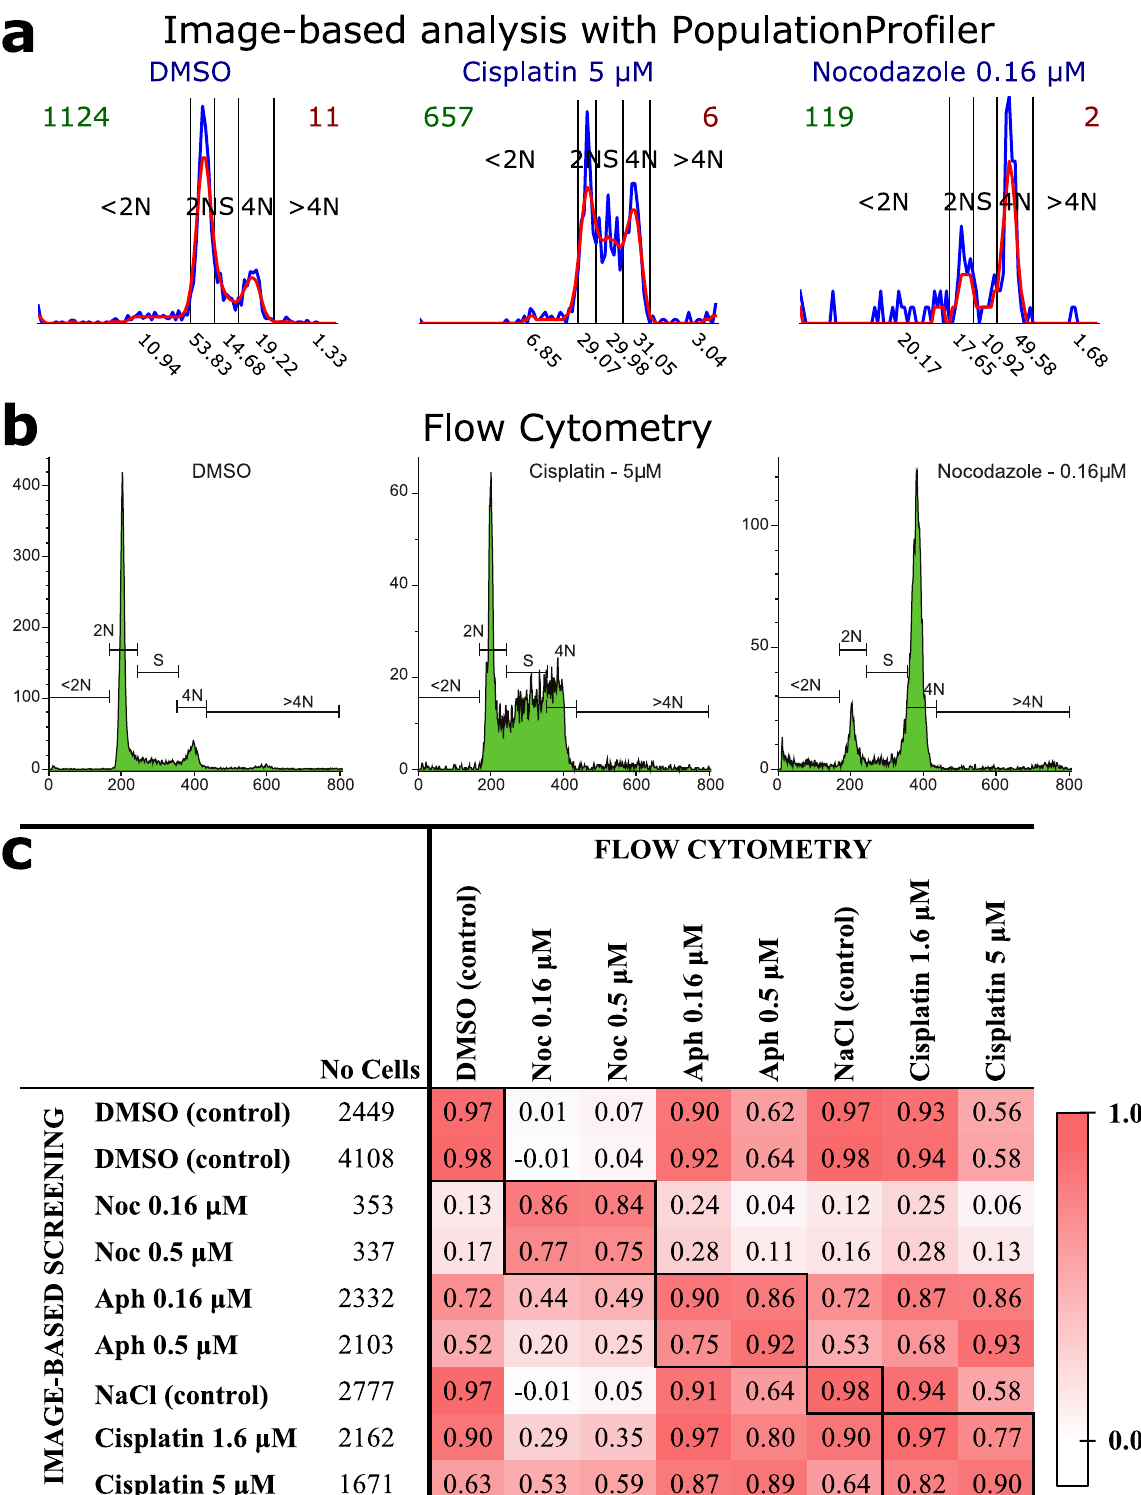
Fig 1. Image-based cell cycle analysis of cell line A549 with PopulationProfiler and its comparison to flow cytometry. a) DNA content histograms created with PopulationProfiler. The blue and red lines show data before and after smoothing, respectively. The numbers under the x-axis present the percentage contribution of each cell cycle sub-population. b) The corresponding cell cycle analysis with flow cytometry. c) A comparison of the results (the